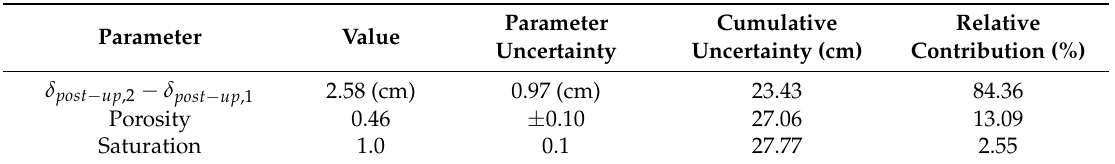
Table 1. Model’s parameters, the uncertainties of each parameter, cumulative uncertainty, and relative contribution in the model for estimating changes in the